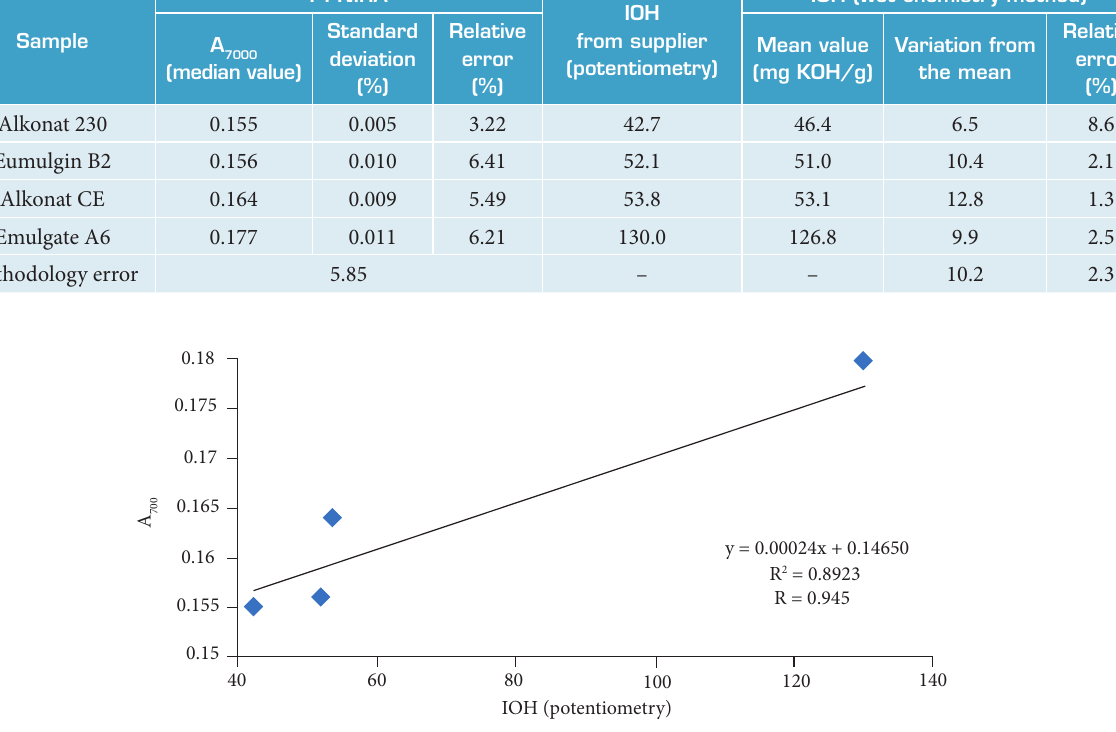
versus IOH 7000